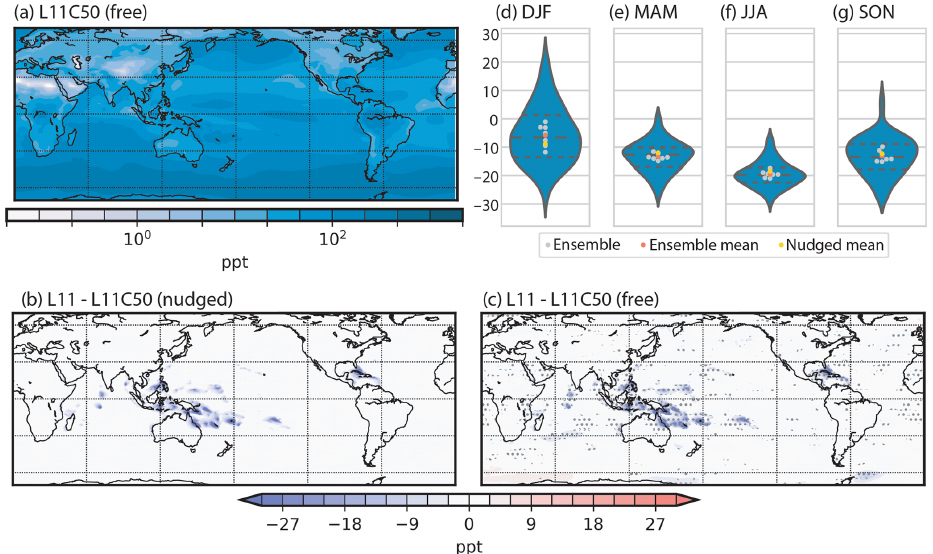
Figure 4. The annual surface DMS a concentration (ppt) for the L11C50 simulation (a) and the L11–L11C50 difference for the nudged simulations (b) and free-running ensemble (c) . In panel (c) the model agreement, where at least five of the seven ensemble pairs agree in the sign of the difference, is shown by stippling. Panels (d) – (g) show violin plots of the average seasonal difference (L11–L11C50) in DMS a over the MC-Aus region as a percentage, where all years in the ensemble are shown by the distribution, the dashed lines represent the 25, 50 and 75th percentiles, the grey dots show each pair of models mean difference, red represents the ensemble average and yellow represents the nudged